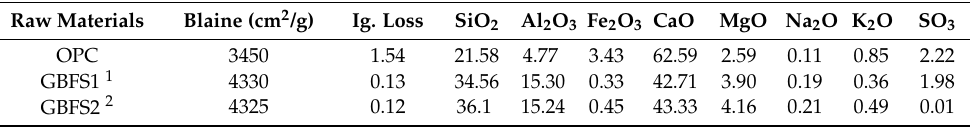
Table 1. Chemical compositions of cement and GBFS (%).